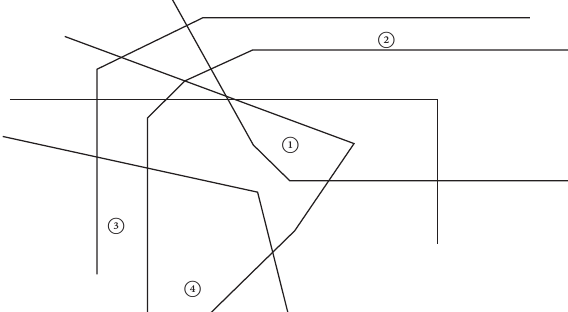
Figure 4: Spatial distribution of selected scenic spots.